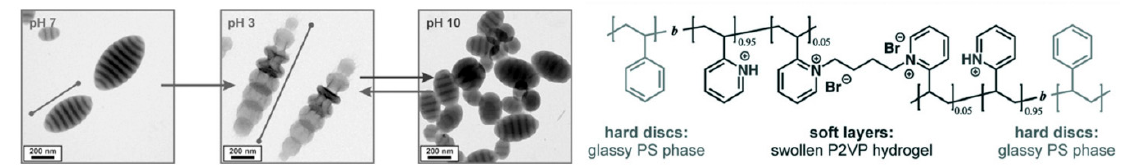
Figure 5. pH-triggered dynamic shape changes for PS- b -P2VP particles with cross-linked P2VP domains as a result of swelling/deswelling of the P2VP-based hydrogel discs (reprinted with permission from [39], Copyright 2014, Wiley-VCH).